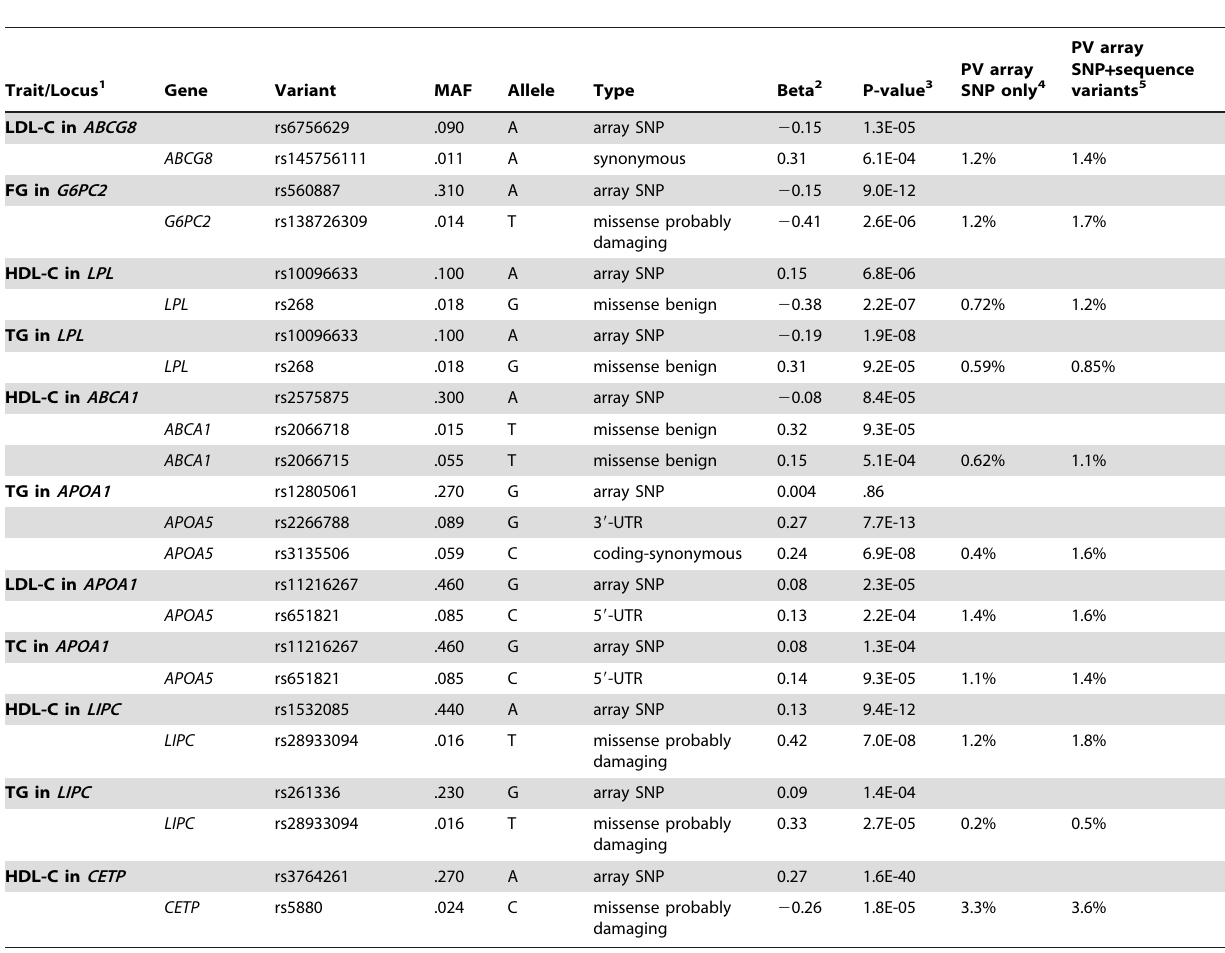
Table 2. Loci with multiple independent single-variant association signals to SNPs with MAF . 0.1%.